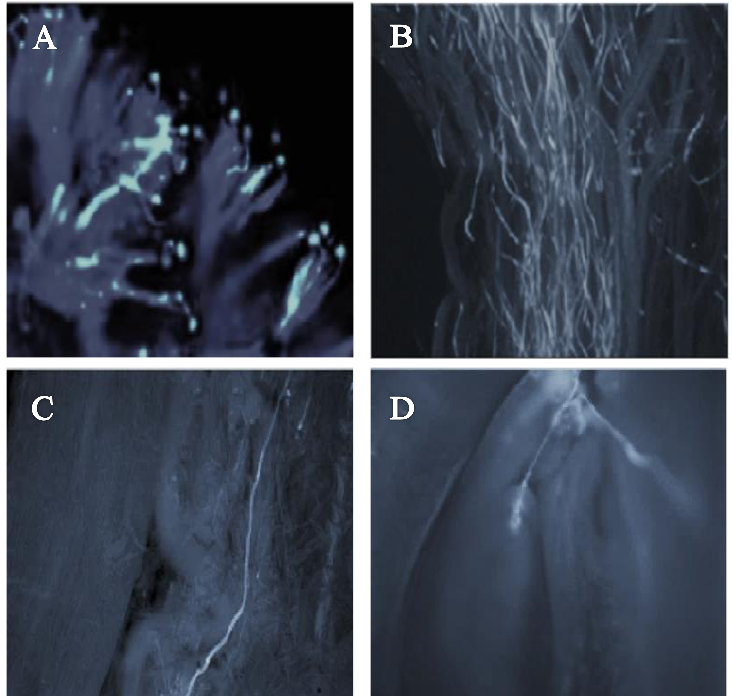
Figure 4. Pollen germination and pollen tube growth in pistil of the cultivar ‘Satluj Purple’ under cross-pollination with ‘Kala Amritsari’ (magnified 200 × ). ( A ) Pollen germination at stigmatic surface; ( B ) Pollen tube growth in the upper half of the style; ( C ) Pollen tube growth in the lower half of the style; ( D ) Pollen tube reaching the ovary region and penetrating one of the ovules of ‘Satluj Purple’.